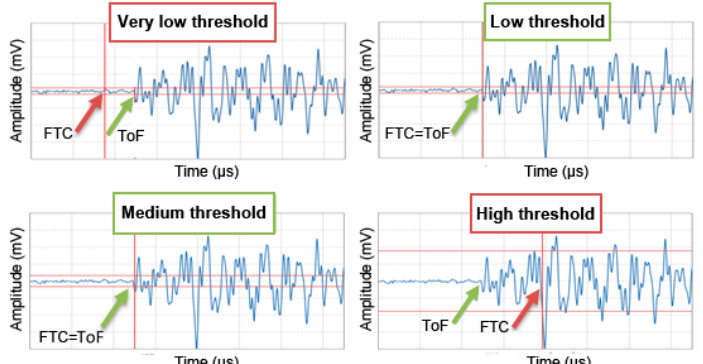
Figure 2. ToF and first threshold crossing (FTC) for different threshold values. Horizontal red line is the selected threshold. Vertical red line corresponds with the FTC; erroneous detection of the ToF (in red); and correct detection of the ToF (in green).